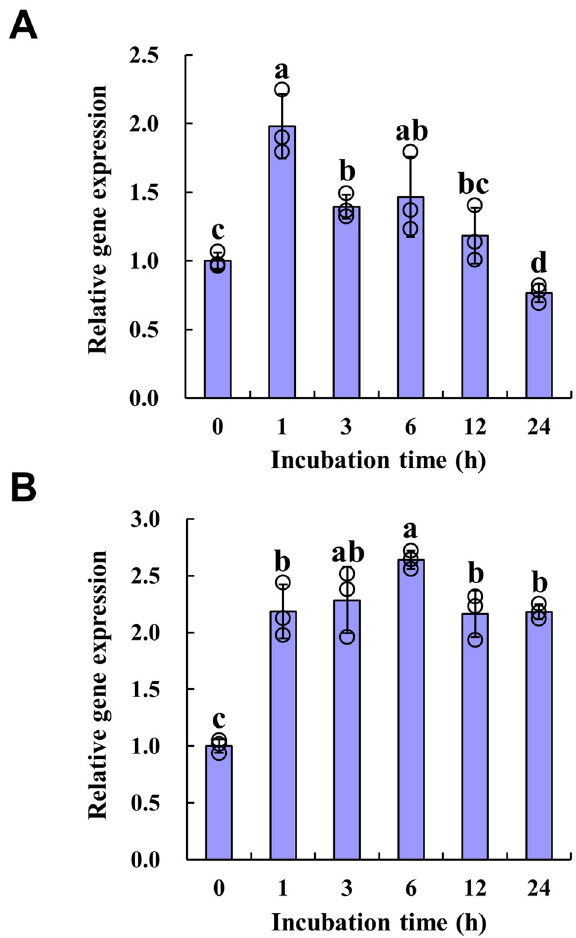
Figure 1. The induced expression of UGT74D1 gene by 10 μM IAA ( A ) or 10 μM IBA ( B ). The relative transcript level was normalized to the transcript abundance of Actin 2 gene. The statistical significance of the difference was confirmed by ANOVA at α = 0.05 level. Error bars indicate SD from triplicate